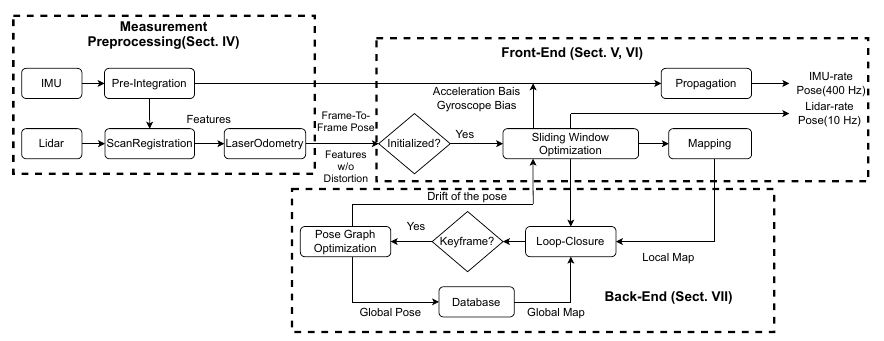
Figure 1. Architecture of the developed RTLIO. Let body frame b k be defined on the IMU, where k denotes the frame when the k th LiDAR measurement is acquired. The world frame w is defined on the initial body frame, and the direction of the gravity is aligned with the z axis of the world frame. The LiDAR frame l be defined on the LiDAR. The rotation from frame A to frame B is denoted as q B or R B , and the translation transforming from frame A to frame B is denoted, as p A A represents the Hamilton product between two quaternions. All other variables are listed